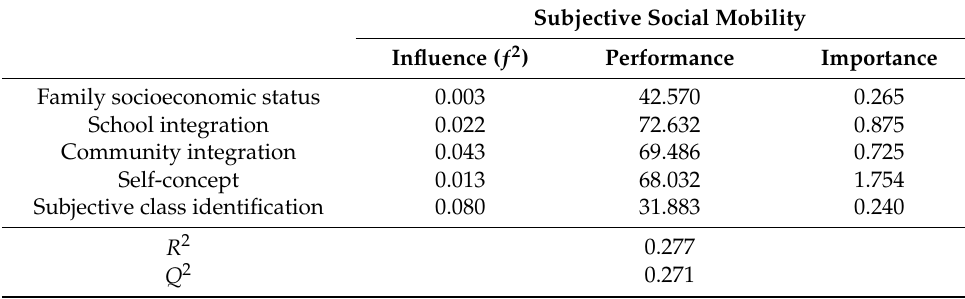
Table 7. Influence, performance, and